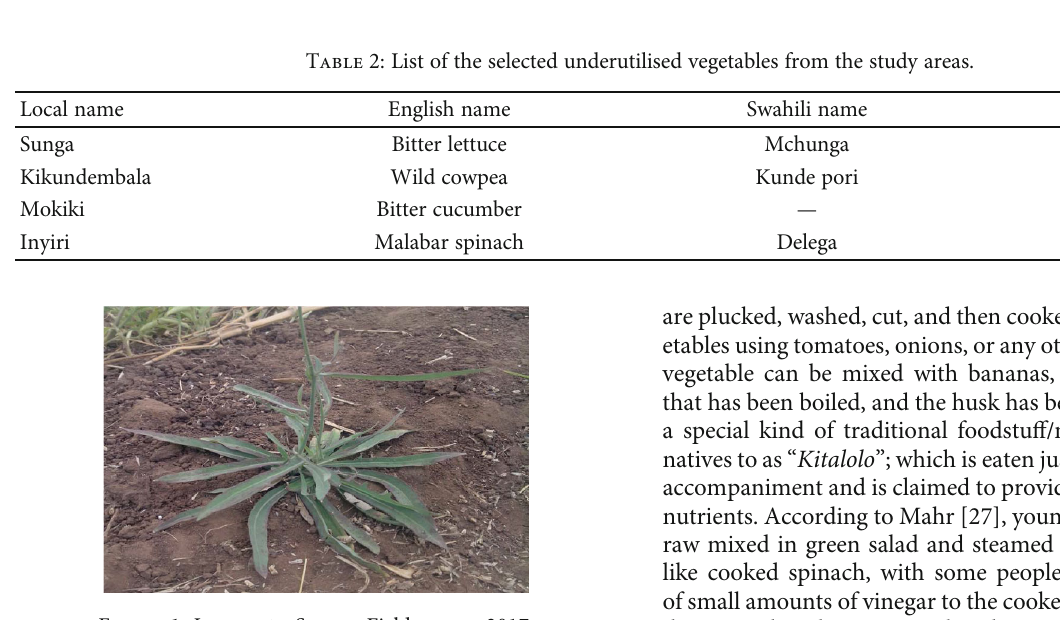
Figure 1: L. cornuta. Source: Field survey,